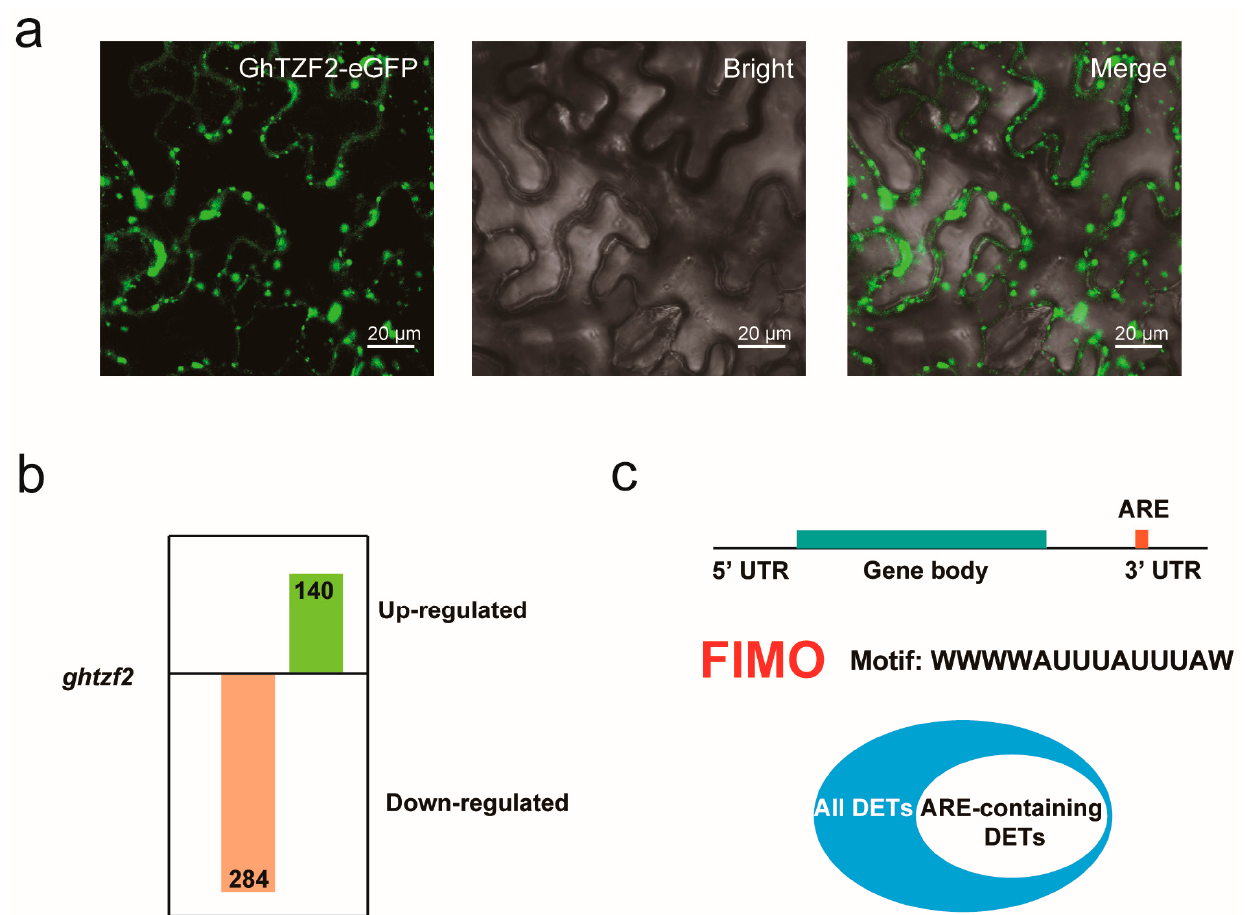
Figure 6. GhTZF2 is localized in granules and causes differential expression of transcripts containing ARE in 3’ UTR. ( a ) Sub-cellular localization of GhTZF2 showed granule-shaped signals. Bar = 20 µ m. ( b ) Transcripts altered in GhTZF2 -knockout lines through transcriptome analysis. There were 140 transcripts up-regulated and 284 down-regulated. ( c ) Transcripts altered in GhTZF2 -knockout lines were identified to contain ARE motif by FIMO with MOTIF “WWWWAUUUAUUUAW”. ARE, AU-rich element; DETs, Differential Expressed Transcripts.